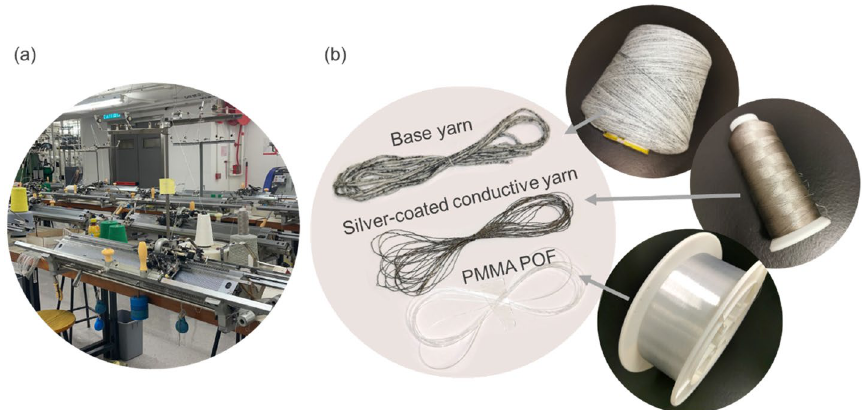
Table 1 Specification of materials used for the knitted e-textile